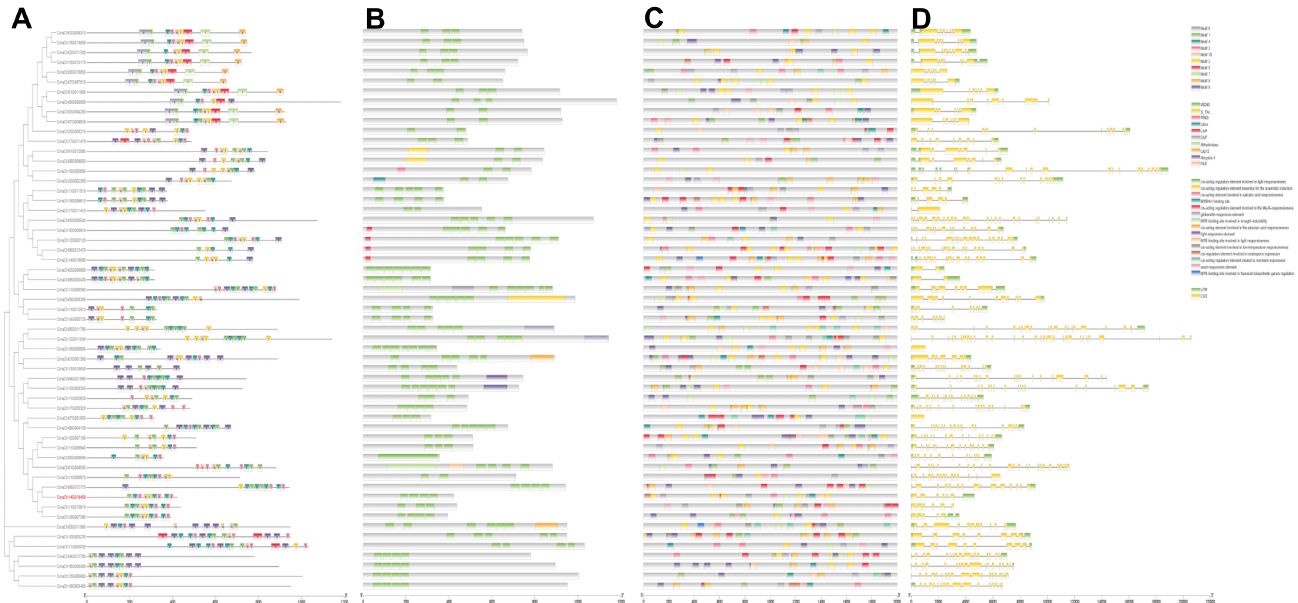
Figure 5. Phylogenetic analysis, conserved motifs, domains, promoter region analysis, and gene structure of WD40s. ( A ) Phylogenetic analysis of 57 Clade III C. maxima WD40s and conserved motifs of WD40s. Boxes of different colors represent 10 putative motifs. ( B ) Diversified protein domains in WD40s. The WD40 repeats are in green, while the other domains are marked in different colors. ( C ) Cis-elements in the promoter region of WD40s. ( D ) Exon/intron organization of WD40s. UTRs are green rectangles, exons are indicated in yellow rectangles, and the black line connecting two exons represent introns. The image was made with